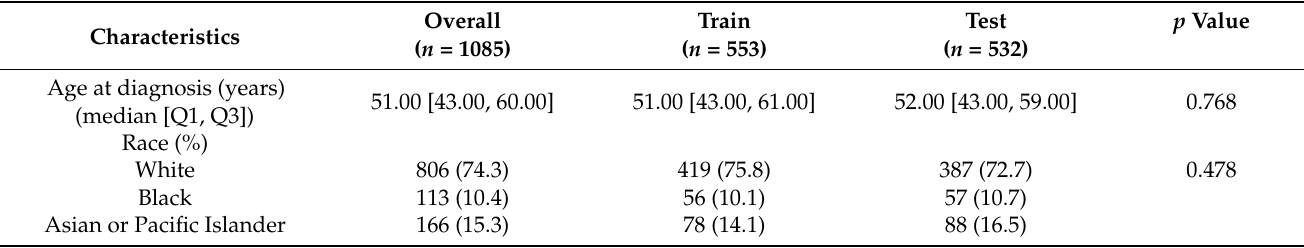
Table 2. Demographic features of patients with malignant phyllodes